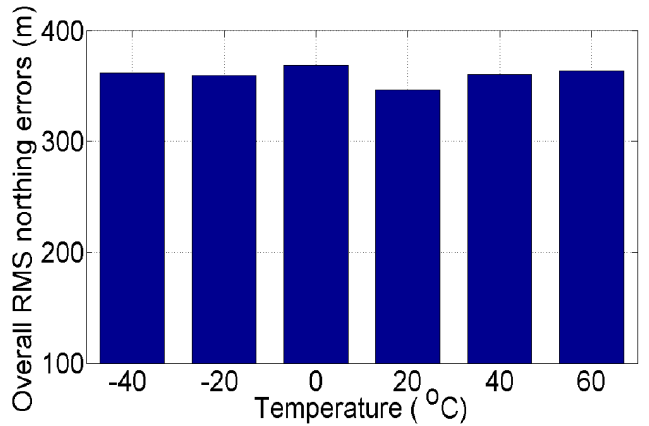
Figure 13. Overall RMS errors in northing using kinematic test data collected at +17 °C and the AR-based GM model developed at different temperature